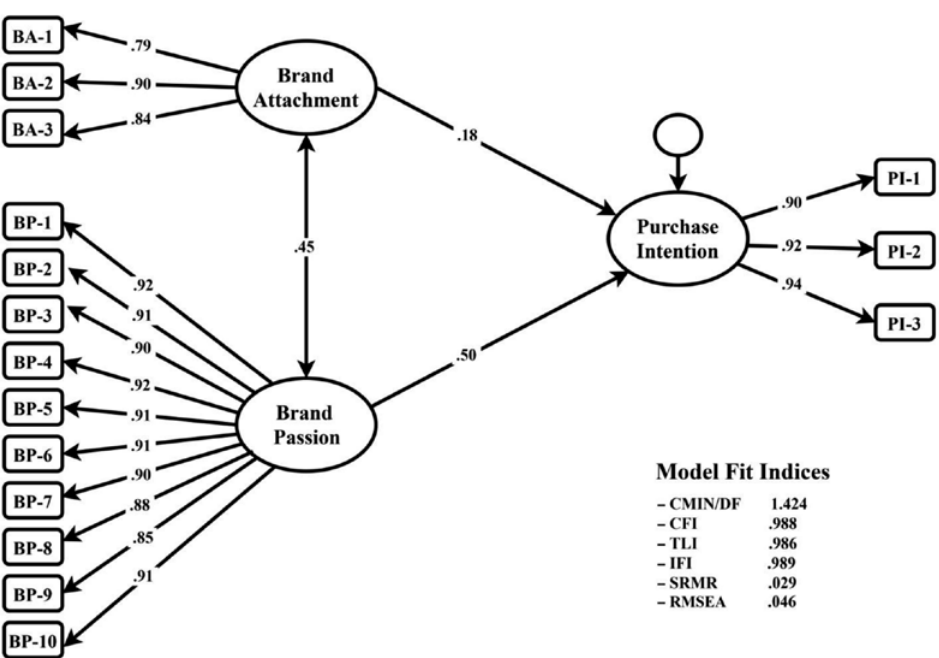
Figure 3. Estimated theoretical framework